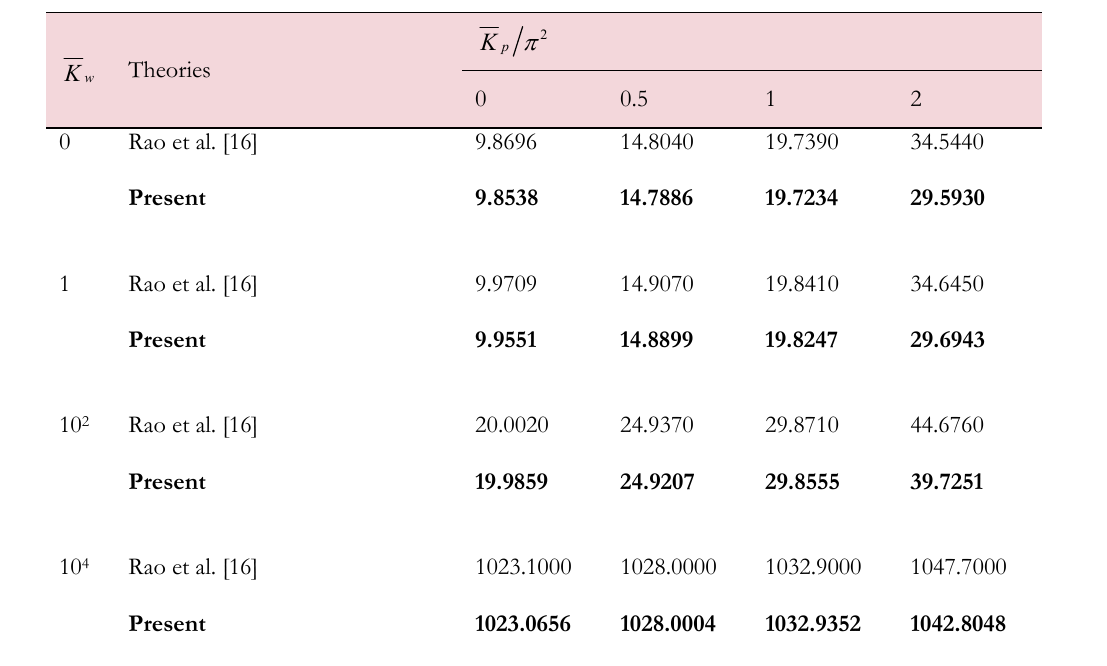
Table 2 Comparisons of buckling load parameter N of an isotropic-homogeneous beam on elastic foundations L/h = 20